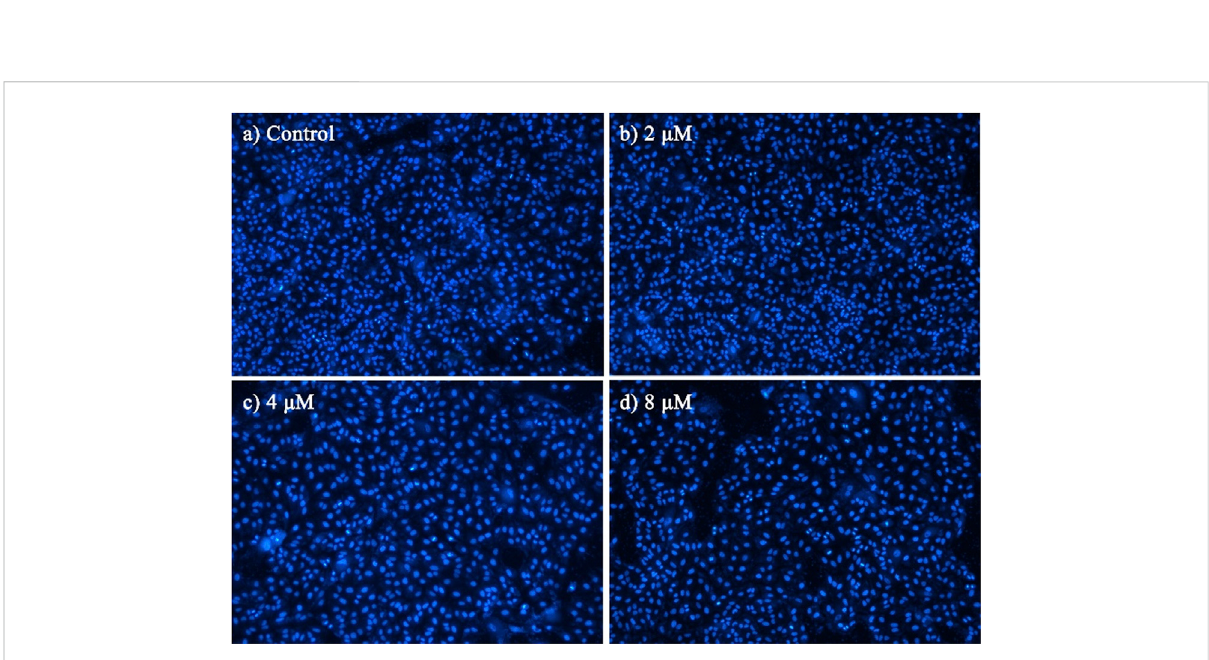
samples made by every fi ve samples before analysis. After fi ve samples were tested during the analysis run, the combined QC samples of the fi ve samples were taken.